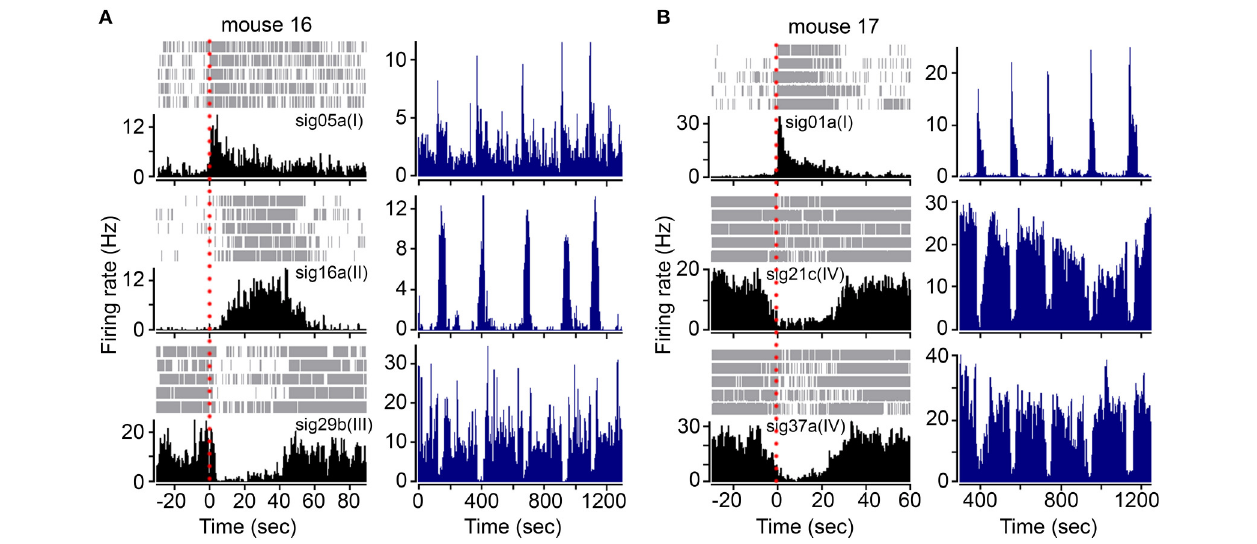
Frontiers in Behavioral Neuroscience |